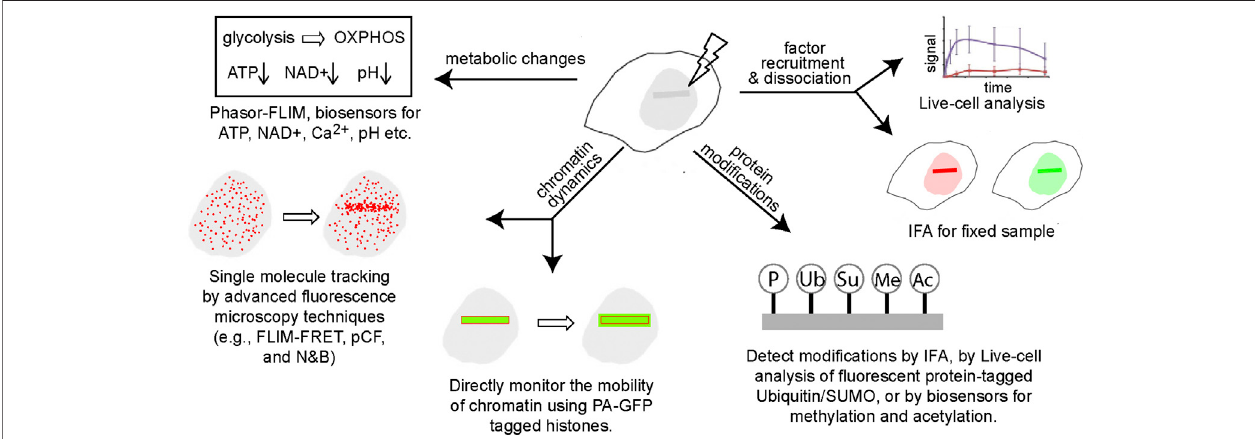
FIGURE2| Applicationoflaserdamagetodissectdifferentaspectsofcellular DDRs.Lasermicroirradiation incombinationwithavarietyof fl uorescencedynamics and imaging techniques allows analyses of cellular DDRs with high spatiotemporal resolution, such as repair factor recruitment and dissociation at the damage sites, protein modi fi cations, chromatin dynamics, and metabolic signaling. These techniques include (clockwise) real-time kinetics analysis of fl uorescently labeled protein recruitment at laser-induced damage sites, immuno fl uorescent staining analysis (IFA) of proteins and covalent modi fi cations at damage sites using speci fi c antibodies in fi xed cells; damage site chromatin movement using fl uorescently labeled histones; high-resolution fl uorescence dynamics analyses of molecular movements and oligomerization using fl uorescently labeled proteins with advanced fl uorescence microscopy techniques, such as FLIM-FRET, pCF and N&B; and analyses of metabolic changes using phasor-FLIM and fl uorescence